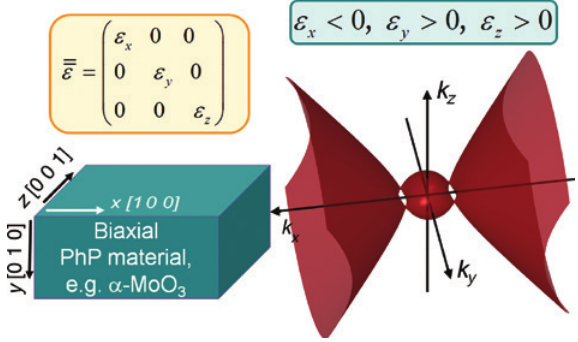
Figure 16: Example of an indefinite photonic response of a biaxial PhP